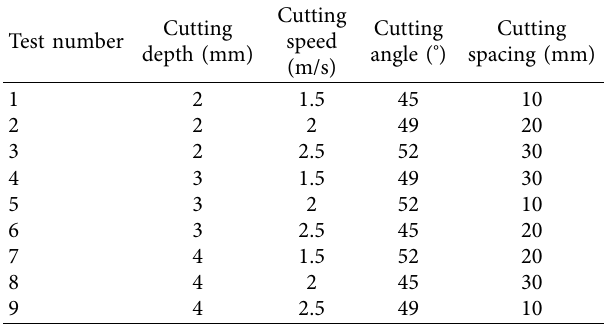
Table 2: Test conditions.